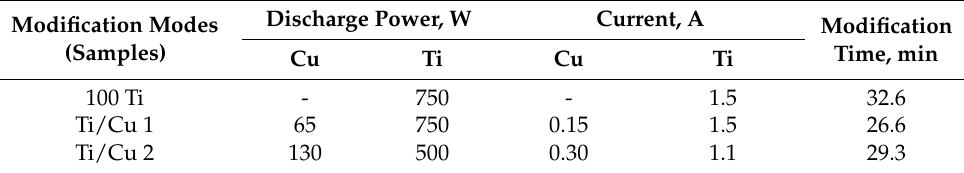
Table 1. Magnetron modification modes of vinylidene fluoride with tetrafluoroethylene (VDF-TeFE) scaffolds by titanium and copper.